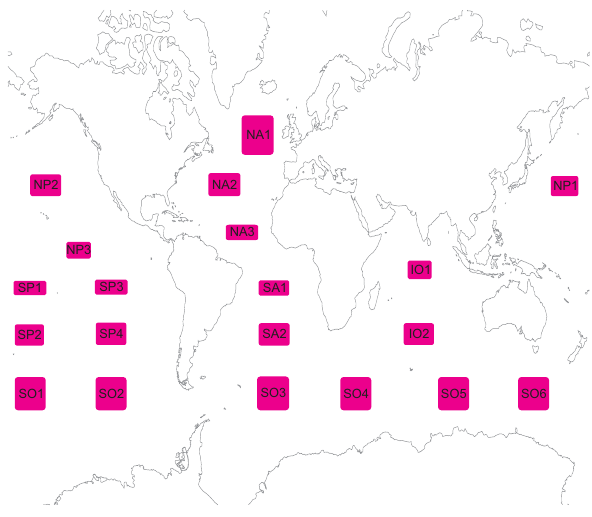
Fig. 2. The location, size and names of the 20 patches used in this